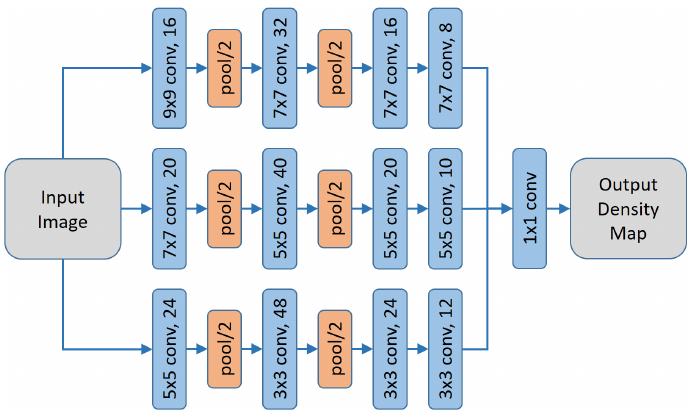
Figure 3. Multi column convolutional neural network (CNN) for person counting